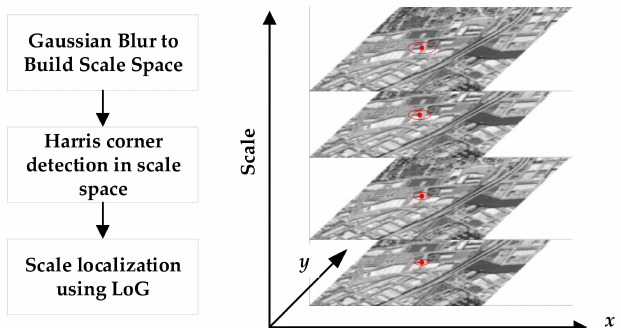
Figure 1. Har-Lap detection process.